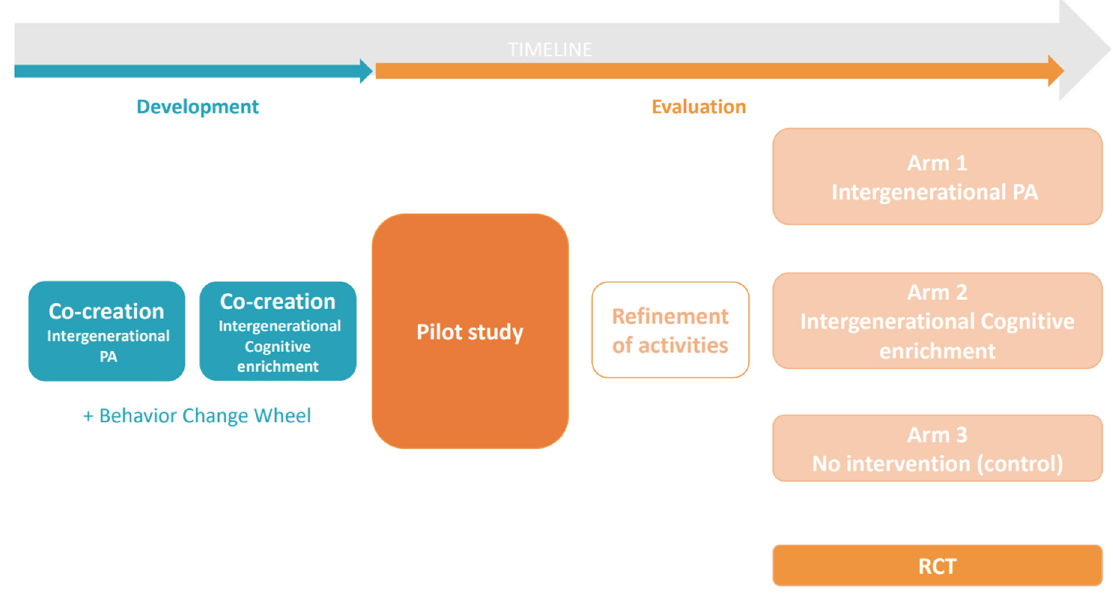
Figure 1. Overview and timeline of the GRANDPACT Project.